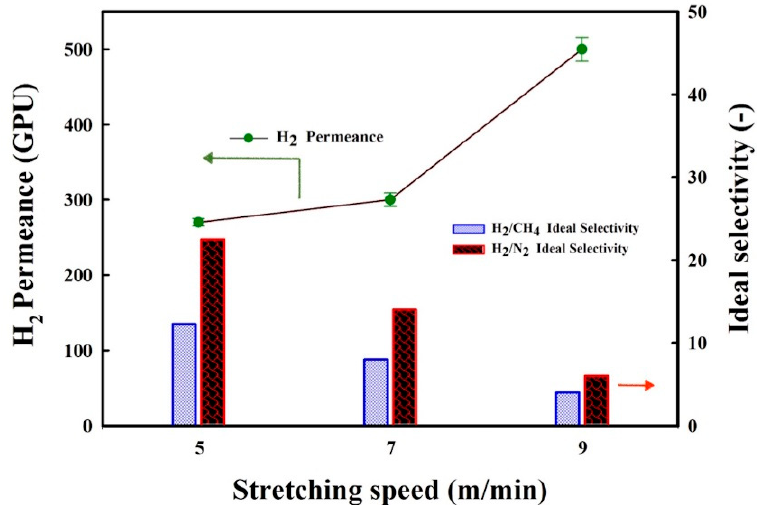
Figure 16. Results for H 2 gas permeance and H 2 /CH 4 and H 2 /N 2 ideal selectivity at 30 ° C and 30 psia for MMFM15 at different stretching speeds.